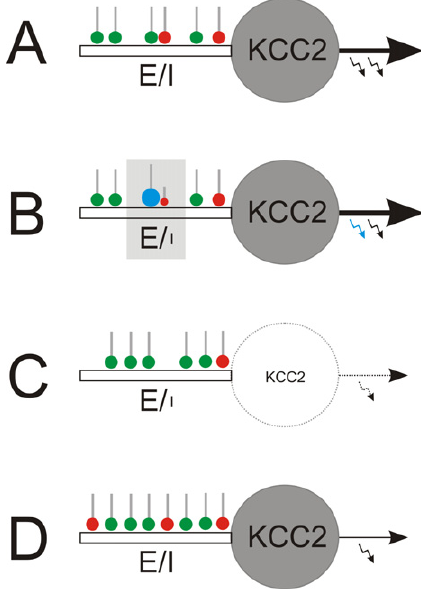
Figure 1. Local and global regulation of the E-I balance. (A) Starting point: homeostatically established E-I ratio of synaptic inputs to mature neurons with KCC2. (B) Local regulation: The E-I ratio of synaptic input can locally be enhanced to facilitate long-term potentiation of glutama- tergic synapses (green). This strengthens glutamatergic inputs (blue) that temporally coincide with the neuronal output (blue arrow). Among others, endocannobinoids were identifi ed as retrograde messengers involved in functional suppression of GABAergic synapses (red) in the neighborhood of potentiated glutamatergic terminals. (C, D) Global regulation. (C) Early in development or in the epileptic brain, where KCC2 expression is low, weak- ening or suppression of neuronal fi ring (silencing) provokes up-scaling of the glutamatergic system and down-scaling of the GABAergic system and, fi nally, elimination of silenced neurons through excitotoxic mechanisms. (D) In contrast, in the mature nervous system, neuron silencing provokes con- comitant up-scaling of both, GABAergic and glutamatergic systems, which homeostatically compensates for reduced neuronal output while keeping the E-I